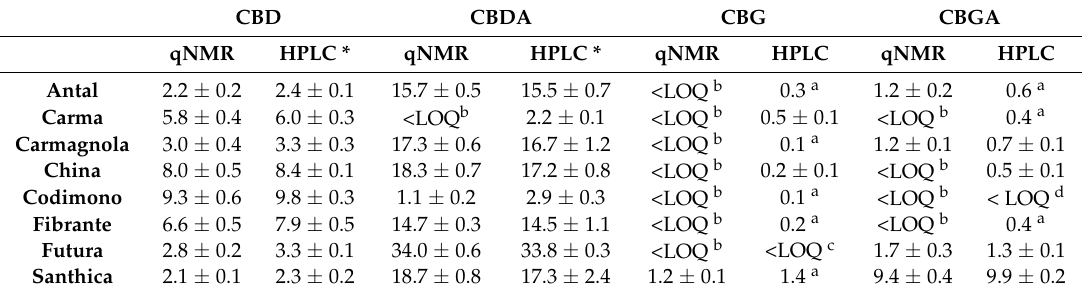
Table 3. qNMR data (mg/g) of cannabinoids in hemp inflorescences compared with HPLC. CBD